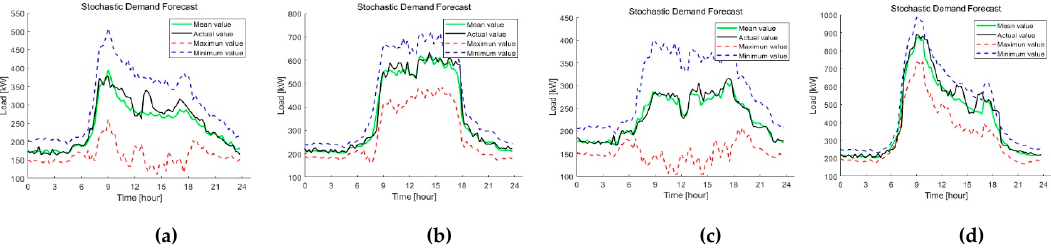
Figure 16. KEPRI stochastic demand forecast. ( a ) Spring, ( b ) Summer, ( c ) Fall, ( d ) Winter.